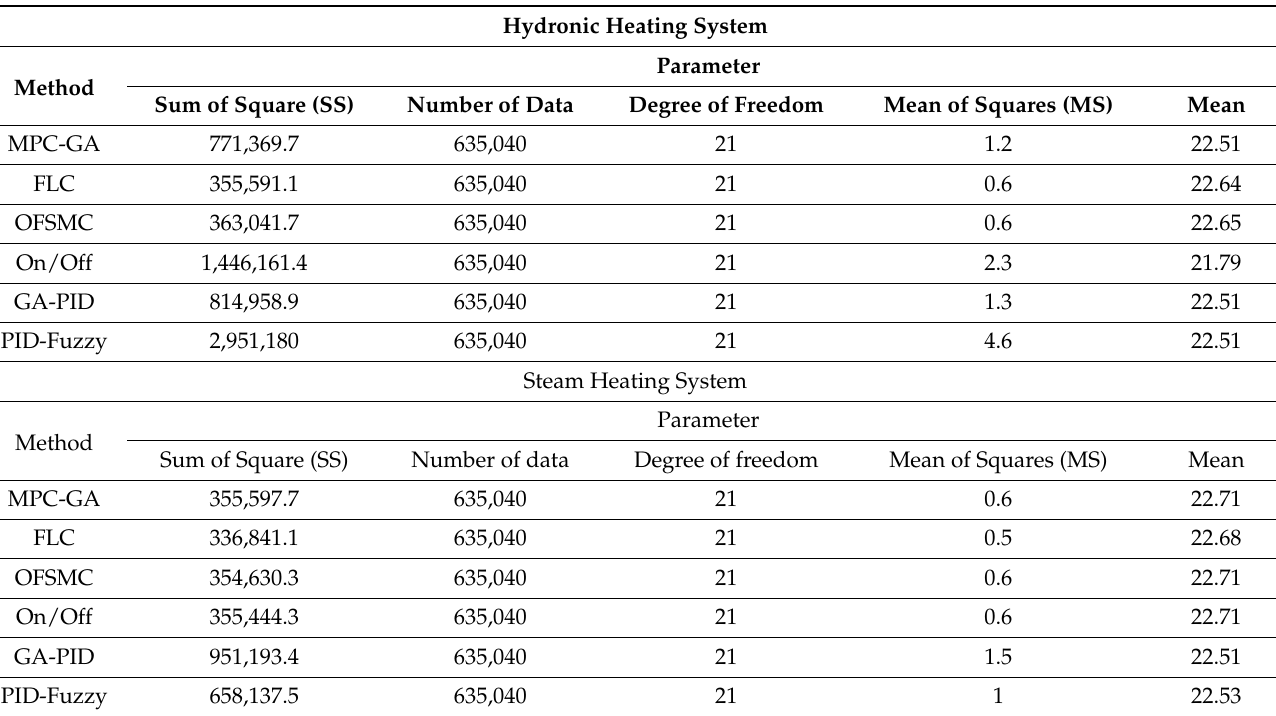
Table 5. ANOVA results for control methods in the different heating